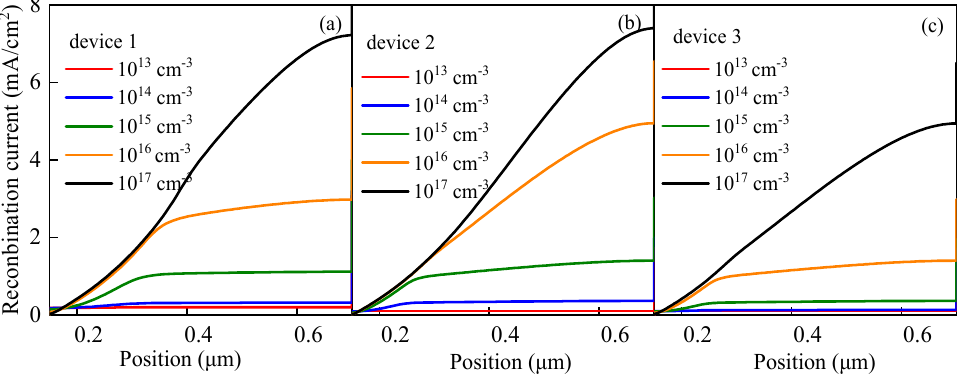
Figure 13. Recombination current at different N t : ( a ) recombination current at different N t in device 1, ( b ) recombination current at different N t in device 2, and ( c ) recombination current at different N t in device 3.